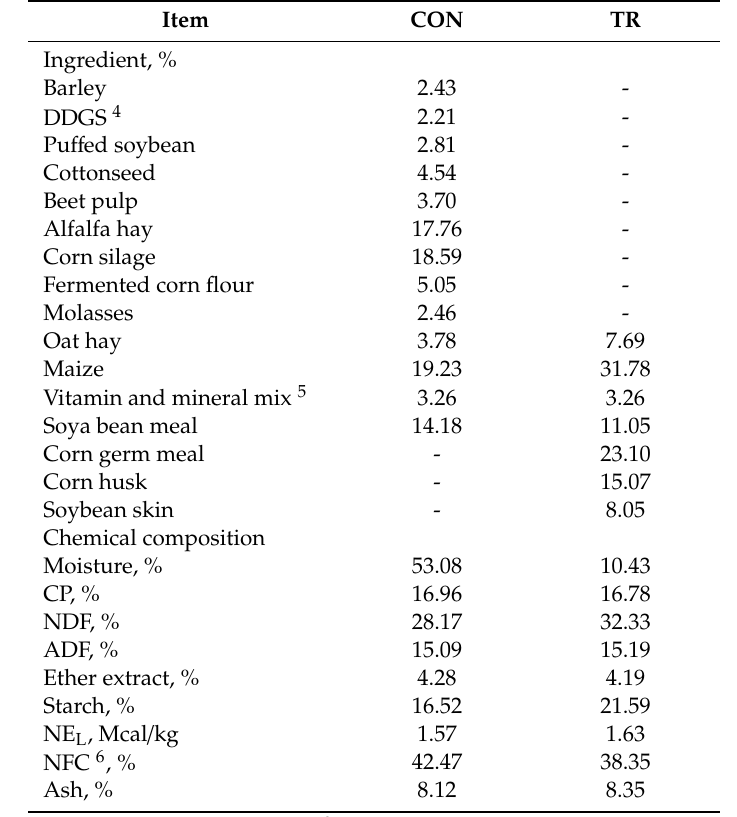
Table 8. Ingredient and chemical composition of CON 1 and TR 2 diets (DM 3